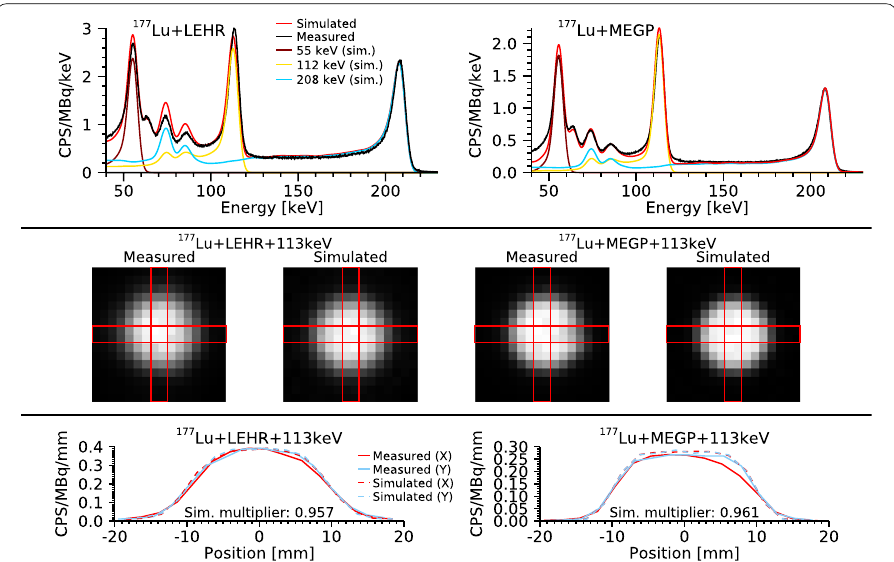
Fig. 6 Comparison of measured and simulated data for 177 Lu with the LEHR and MEGP collimators. Top row: energy spectra. For the simulations, a total spectrum is shown along with the individual contributions of the 55 keV, 113 keV and 208 keV photon emissions of 177 Lu . Middle row: corresponding images of the phantom for the 113 keV energy window. Red lines indicate columns and rows used to extract profiles. Bottom row: Profiles of measured and simulated images, where the simulated images have been scaled to the same total number of counts as the measured